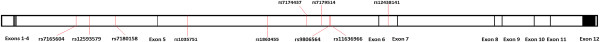
Schematic diagram of GABRB3 showing significant single nucleotide polymorphisms (SNPs). Black lines represent exons. Red lines represent the significant SNPs. There are 12 exons in GABRB3, which are shown.